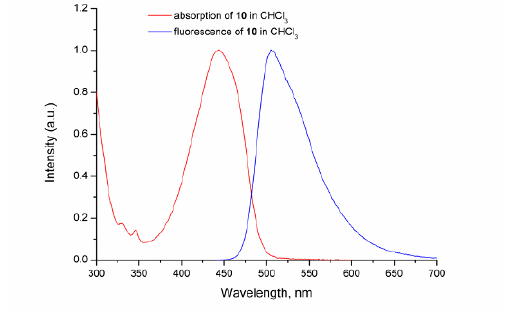
Figure 2. Absorbance and fluorescence spectra of 10 in CHCl